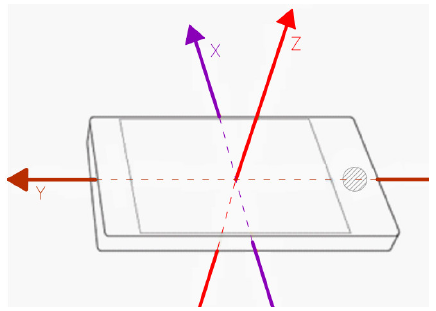
Figure 5. System coordinates of the device [29].